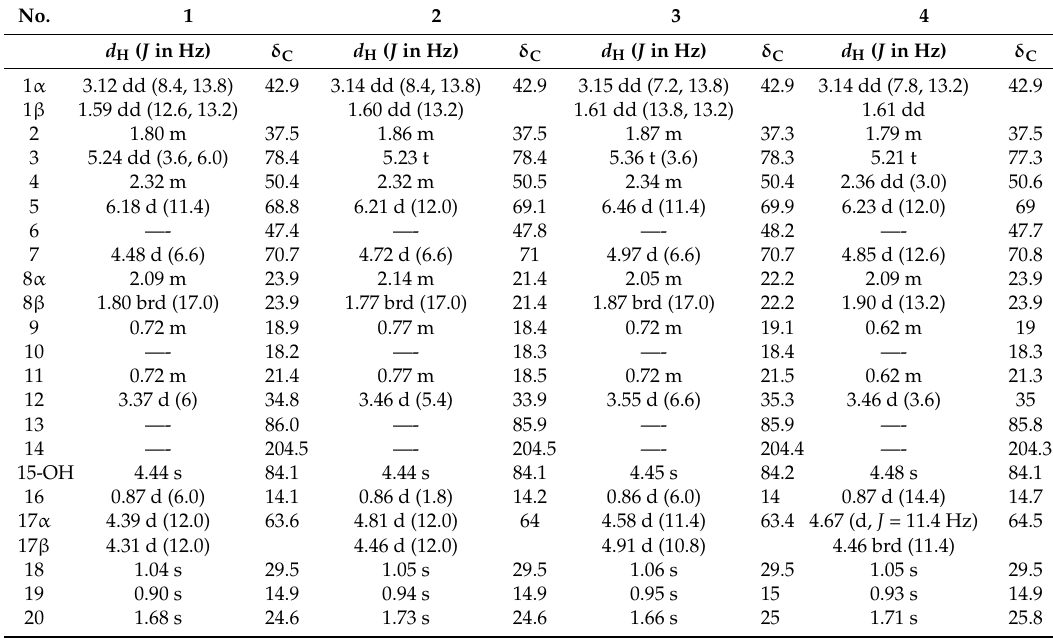
Table 1. 1 H-NMR and 13 C-NMR spectral data of compounds 1 – 5 (600 MHz, δ -ppm).